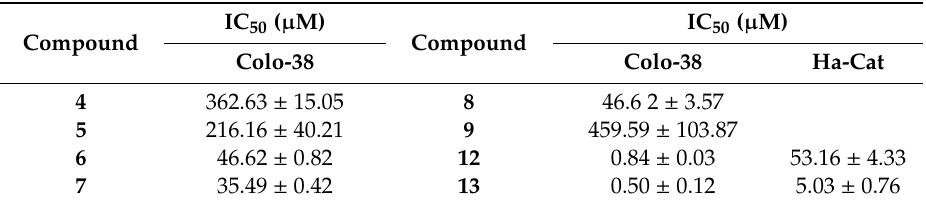
Table 3. E ff ects of selected hydrazone derivatives on the proliferation of melanoma Colo-38 and keratinocyte Ha-Cat human cell